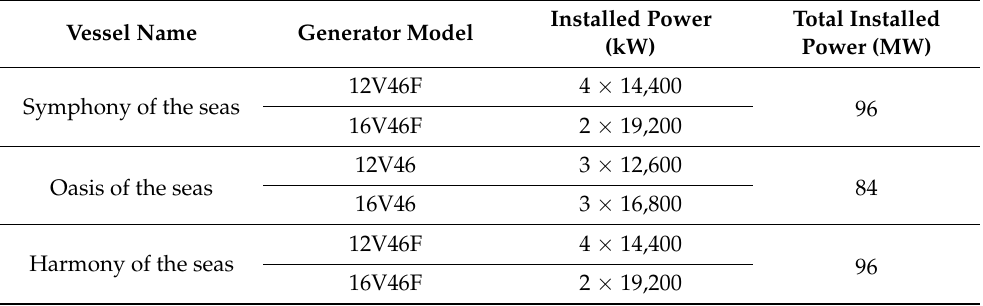
Table 2. Analyzed cruise ships with installed equipment.